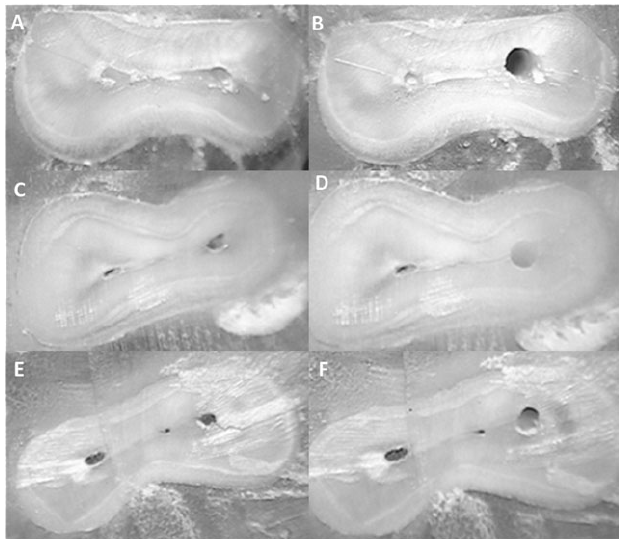
Fig. 1. Pre- and postoperative images showing the centering ability of the ProTaper Universal™ (A and B), ProFile™ (C and D), and Twisted File™ (E and F)